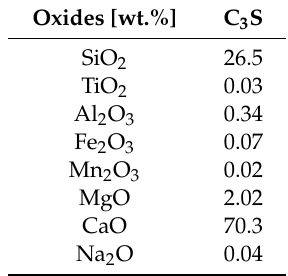
Table 1. Chemical composition of the used C 3 S measured by X-ray fluorescence spectroscopy (XRF). Oxides